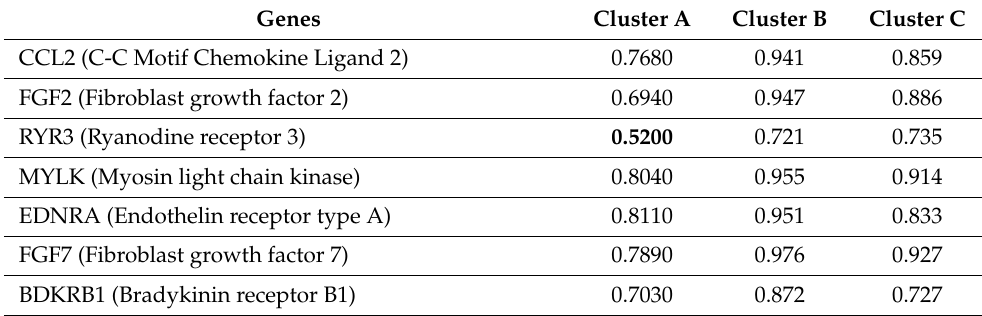
Table 2. The area under the curve (AUC) from specificity and sensitivity of the gene expression level to define each MIBC